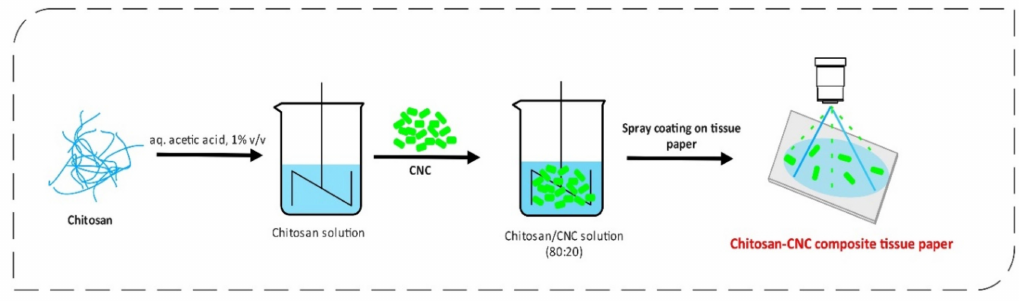
Figure 8. Preparation of chitosan / CNC composite tissue paper that can help prevent the spread of infectious